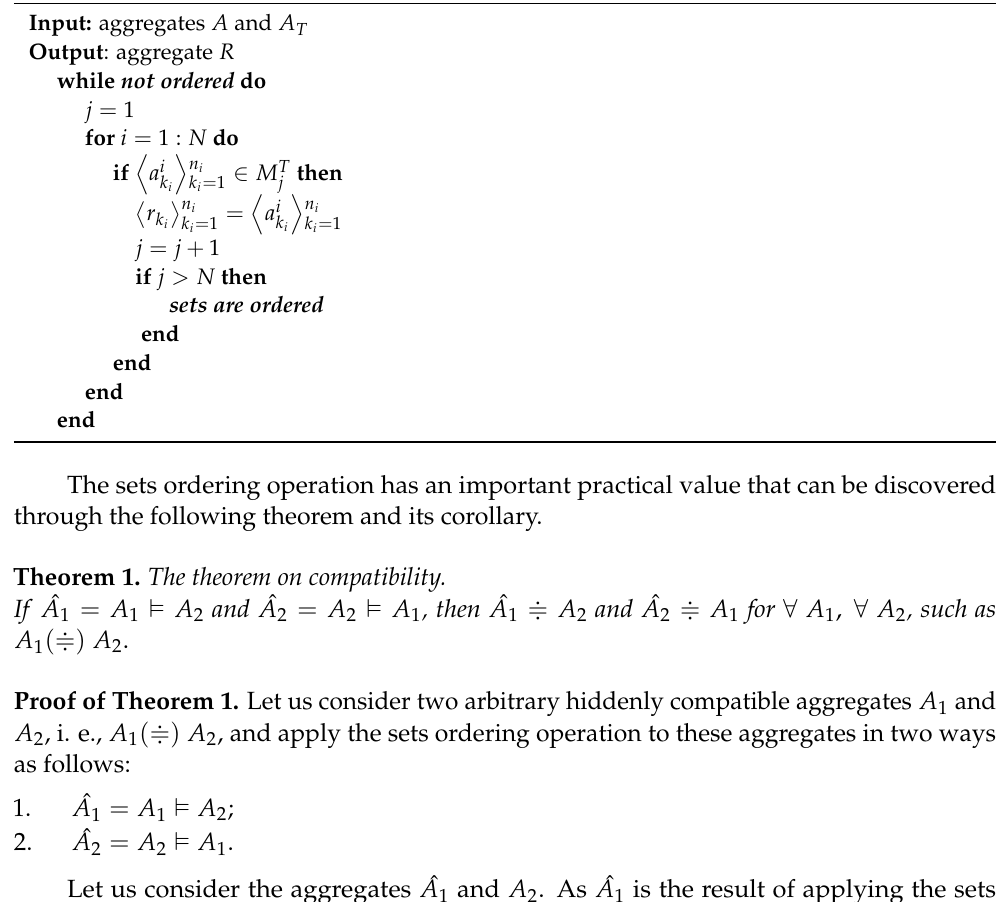
Figure 4. An example of two hiddenly compatible aggregates. Hiddenly compatible aggregates can be made compatible by applying certain oper- ations to them. 5. Algorithms of Operations on Aggregates The operations on aggregates in the ASA include logical operations, ordering opera- tions, and arithmetic operations. 5.1. Logical Operations The logical operations [18] on aggregates are union, intersection, exclusive intersec- tion, difference, and symmetric difference. The result of any logical operation depends on the aggregates’ compatibility. For example, the rule for the union operation can be math- ematically defined as follows. The union of the aggregates 𝐴 (cid:2869) and 𝐴 (cid:2870) is the aggregate 𝑅 ∪ , which contains elements of the tuples that belong to both aggregates and are ordered in the following way: